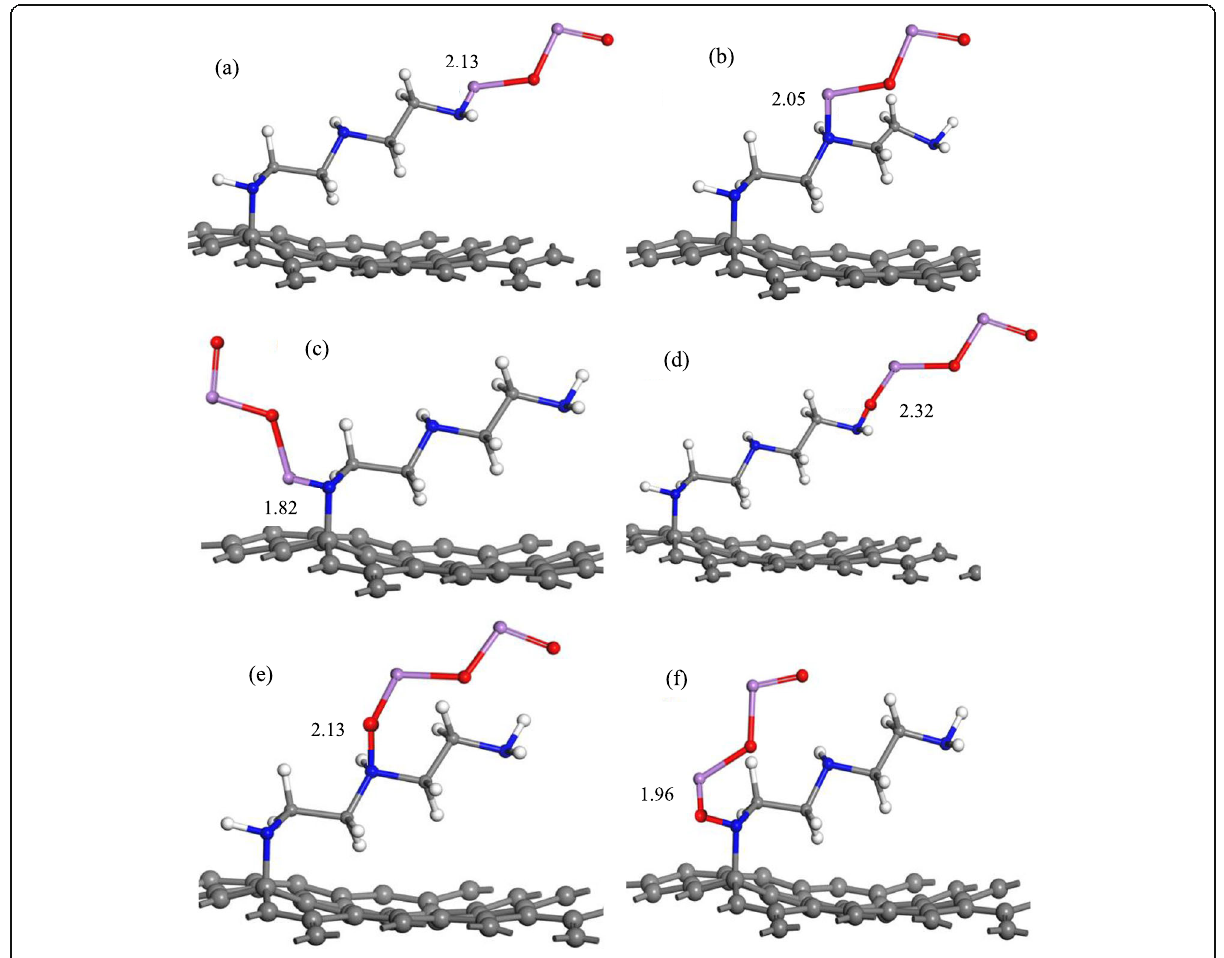
Fig. 10 The possible adsorption configurations of As (III) on DETA-SBC